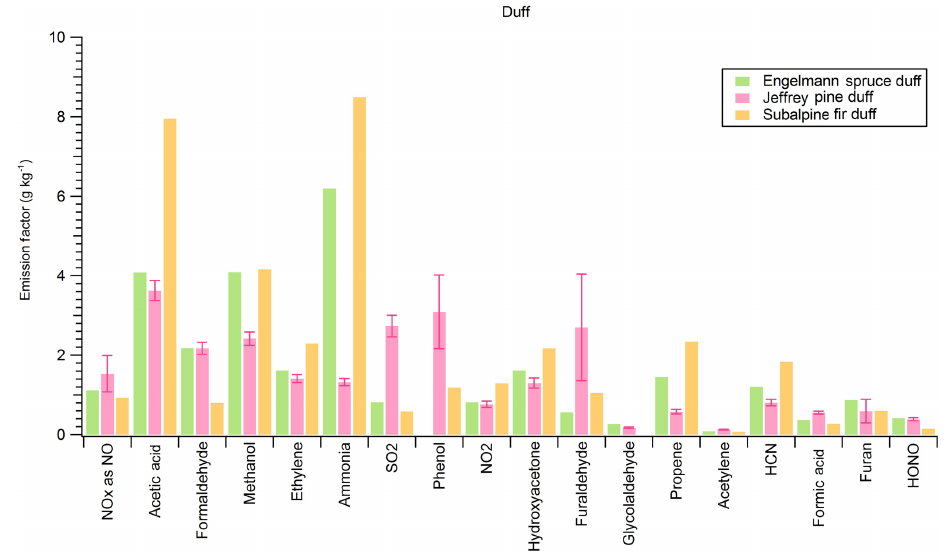
Figure 6. Trace gas emissions from pure duff of three different ecosystem types. Table 3. Lab-average emission factors (m 2 kg − 1 ) and fire-integrated optical properties for common western US ecosystems. Species Douglas Engelmann Lodgepole Ponderosa Chaparral – Chaparral – fir spruce pine pine chamise manzanita Black carbon (gkg − 1 ) 0.23 (0.06)